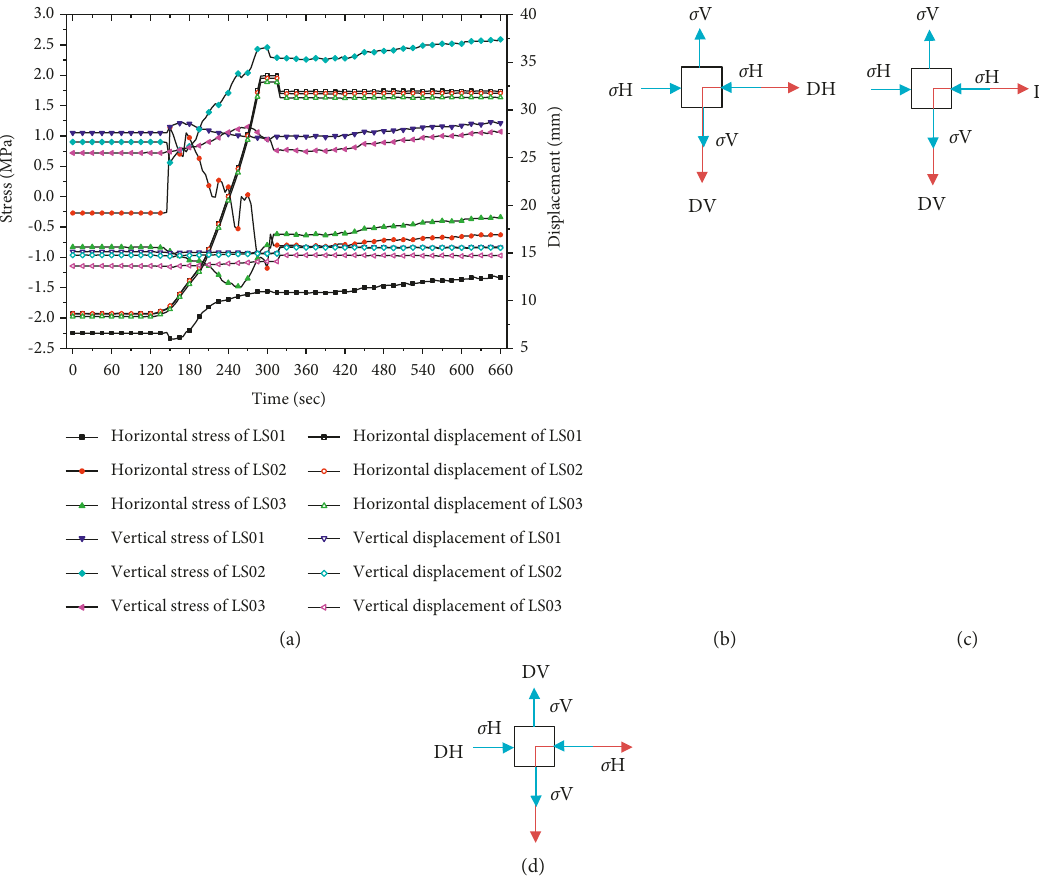
Figure 19: Stress and displacement of roadway left side measuring points when the cumulative duration is 539–550mins; (a) monitoring curve of LS01, LS02, and LS03; (b–d) schematic diagram of LS01, LS02, and LS03,